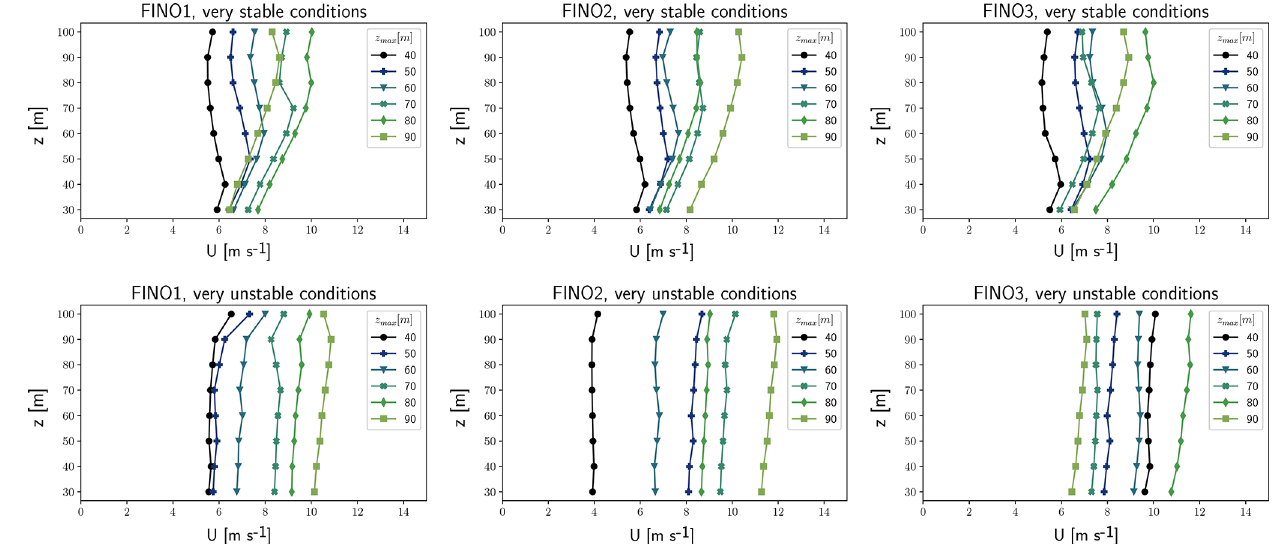
Figure 10. Mean 1-inflection velocity profiles at FINO1, FINO2 and FINO3 with the maximum at different heights, during very stable and very unstable atmospheric stability. The neutral-stability condition is not shown due to a low occurrence.